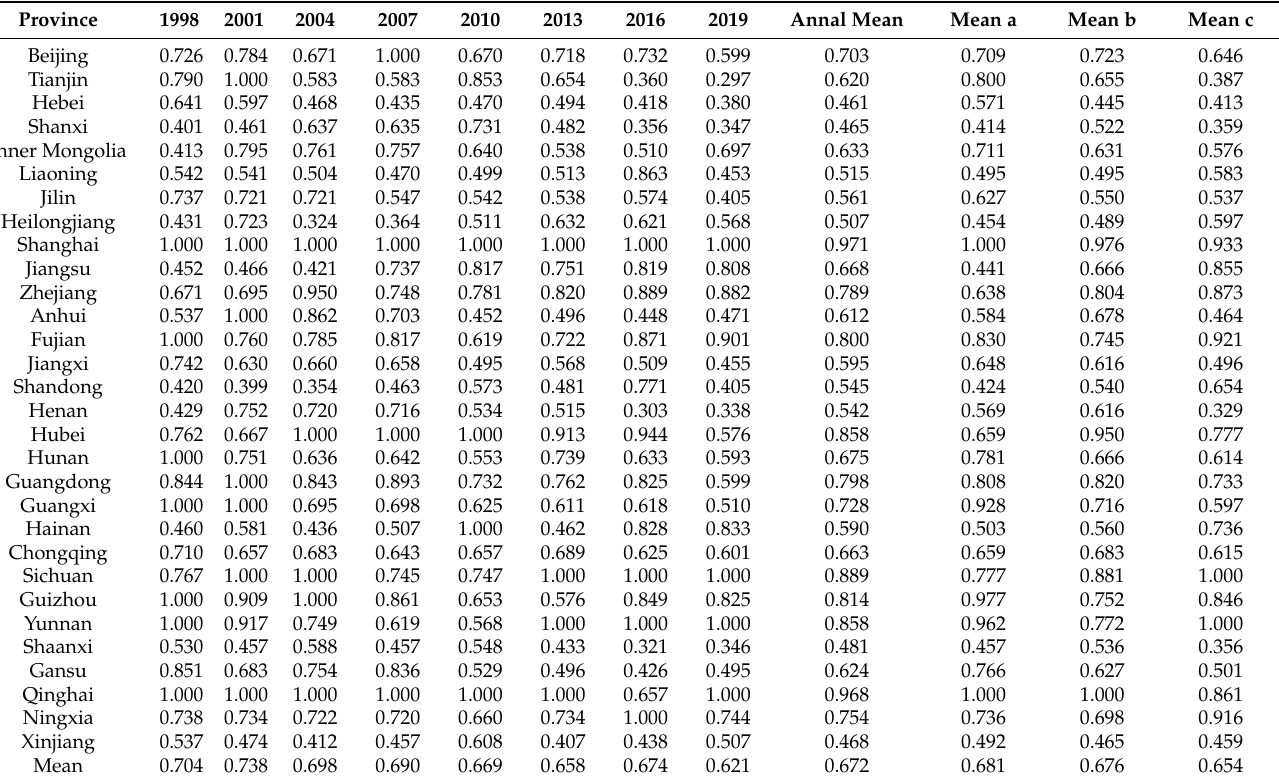
Table 2. The comprehensive level of environmental efficiency of the power industry in China’s 30 provinces of 1998–2019. Province 1998 2001